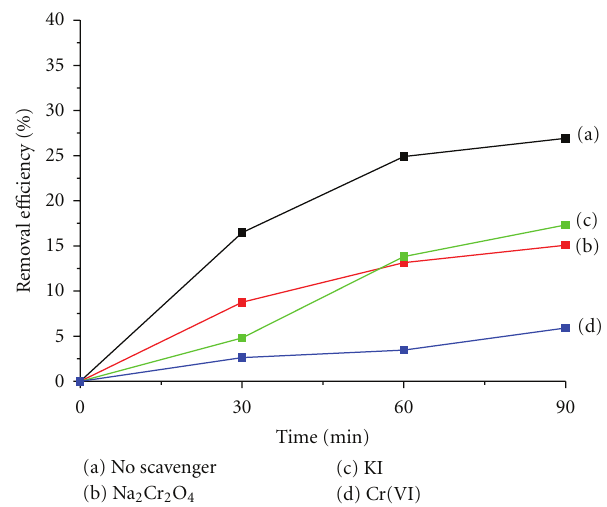
Figure 10: Photodegradation e ffi ciencies of Rh-B (10 μ M, 100 mL) over 0.1g of Nd-doped TiO 2 with Ti:Nd = 11:1 under visible light with the presence of di ff erent scavengers, 5mM sodium oxalate and KI, and 0.5mM K 2 Cr 2 O 6